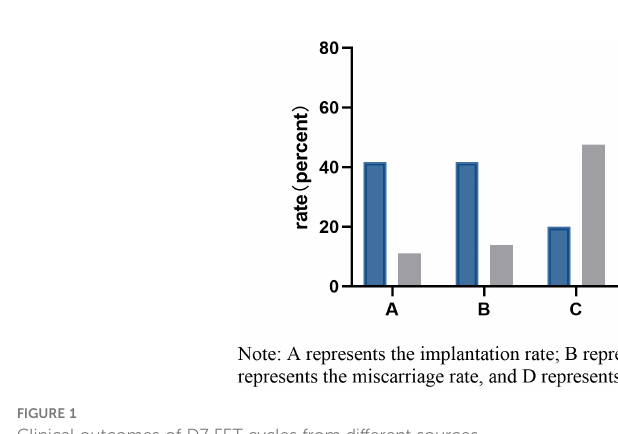
TABLE 4 Comparison of the euploidy rates of D5, D6 and D7 blastocysts in the PGT cycles.